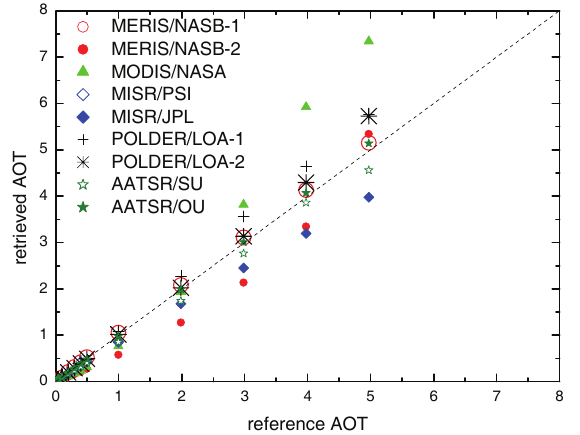
Fig. 9b. The same as in Fig. 9a except for another range of AOT